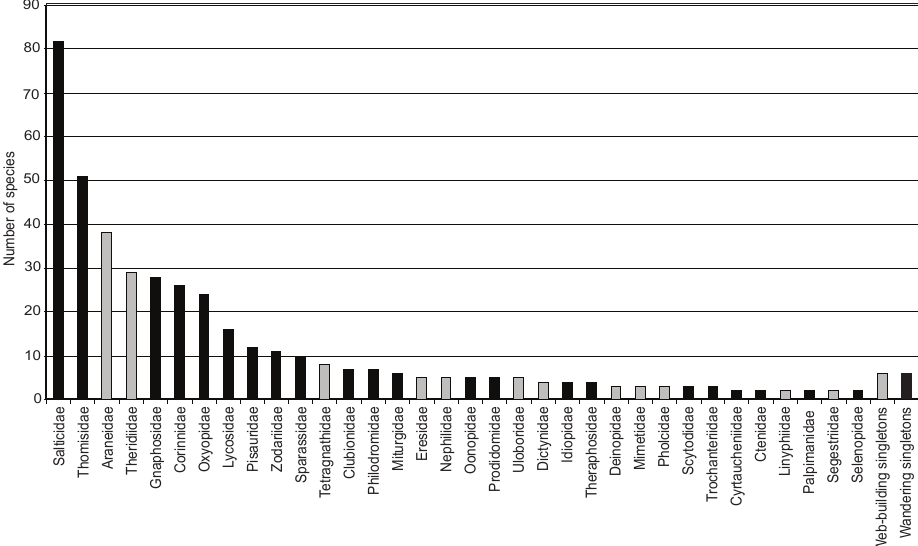
Fig. 14. Species diversity of spider families collected in Ndumo Game Reserve ranked from highest to lowest. Black bars indicate wandering spiders and grey bars indicate